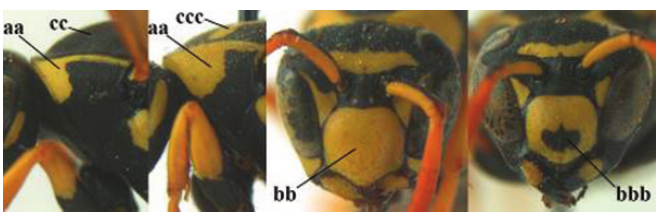
Males 21 Mandible very stout and with a distinct depression on its outer face (a); clypeus depressed medio-apically (b), its margin tapered to a small point (c); malar space comparatively long and wide (d); socio-parasitic species ...................... 22